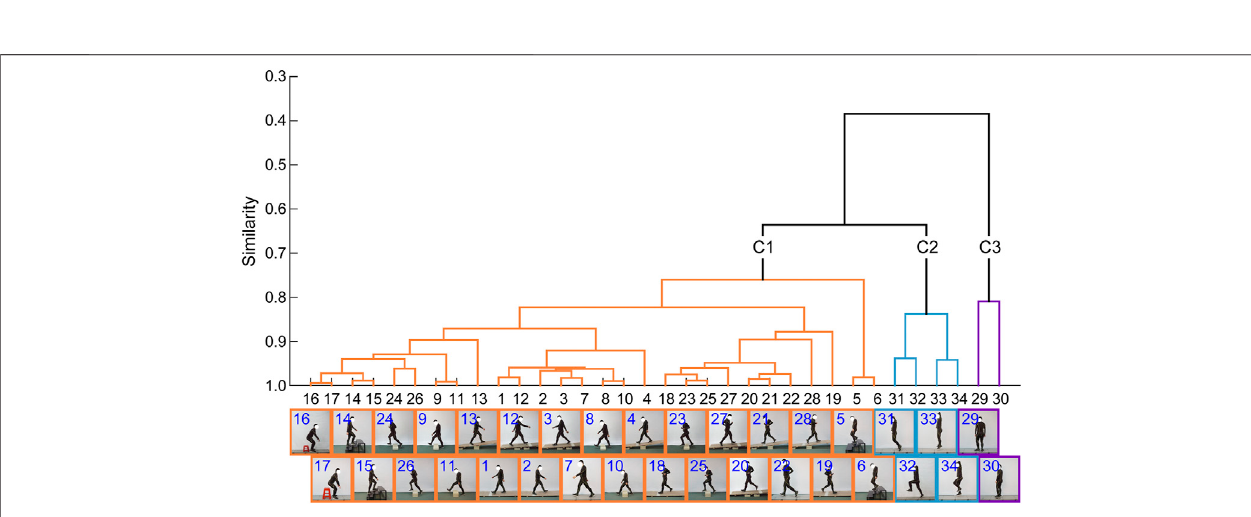
FIGURE 3 | Dendrogram of the lower limb movements. Three clusters (C1 – C3) are identi fi ed in the various lower limb movements based on the synergistic characteristics of the limb movements.